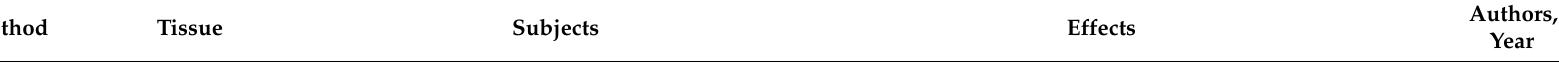
Table 1. MicroRNAs expression in plasma, cerebrospinal fluid, and brain tissues in patients with mesial temporal lobe